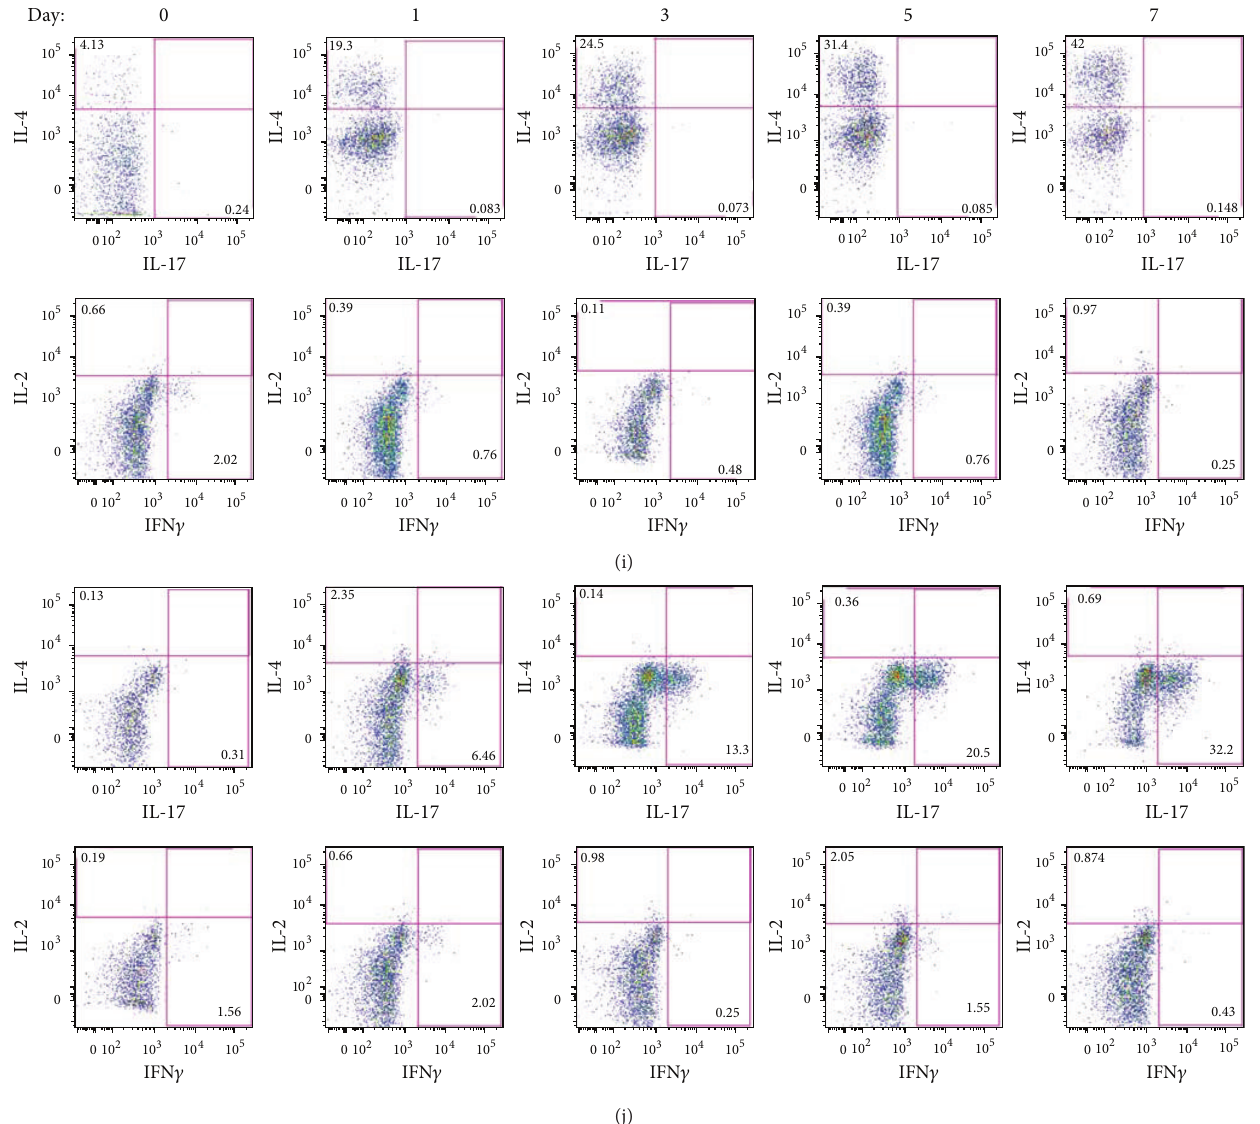
Figure 4: Phe induces conversion of Treg to Th2 Teff. Isolated Tregs were treated with 300 nM Phe (black bars), TCDD (light grey), FICZ (dark grey), or diluent (white bars) for 0 to 7 days and analyzed for cytokine production by immunostaining and flow cytometry. MFIs ( ×10 3 ) are represented on the 𝑦 axes. Th2 Teff phenotype was identified by decreased (a) TGF- 𝛽 and (b) IL-10 production and increased IL-4 (c), pSTAT6 (d), GATA-3 (e), and IL-13 (f), and Th17 phenotype was examined by IL-17 (g) and ROR- 𝛾 -T (h) production. Representative flow cytometry plots of IL-4+ or IL-17+ T cell populations at each time point for Treg treated with Phe (i) or TCDD (j). ∗ 𝑃 < 0.05 ; error bars show